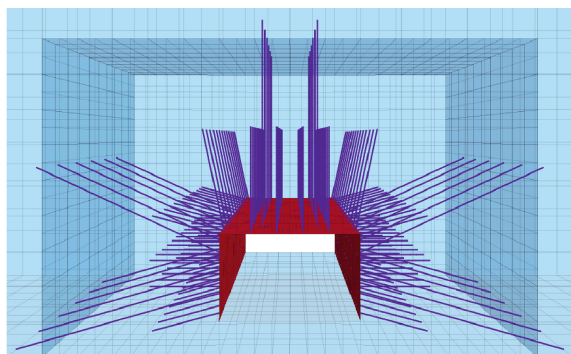
Figure 15: Simulation schematic